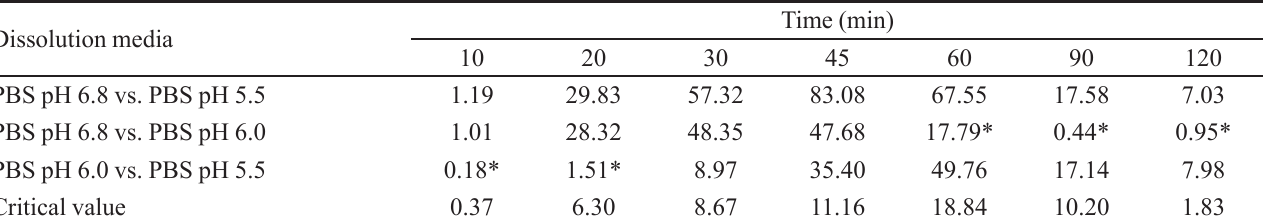
TABLE III - Duncan test ( α=0.05) for EC-MPS dissolution profiles in media PBS pH 5.5, 6.0 and 6.8, using UV method, λ 250